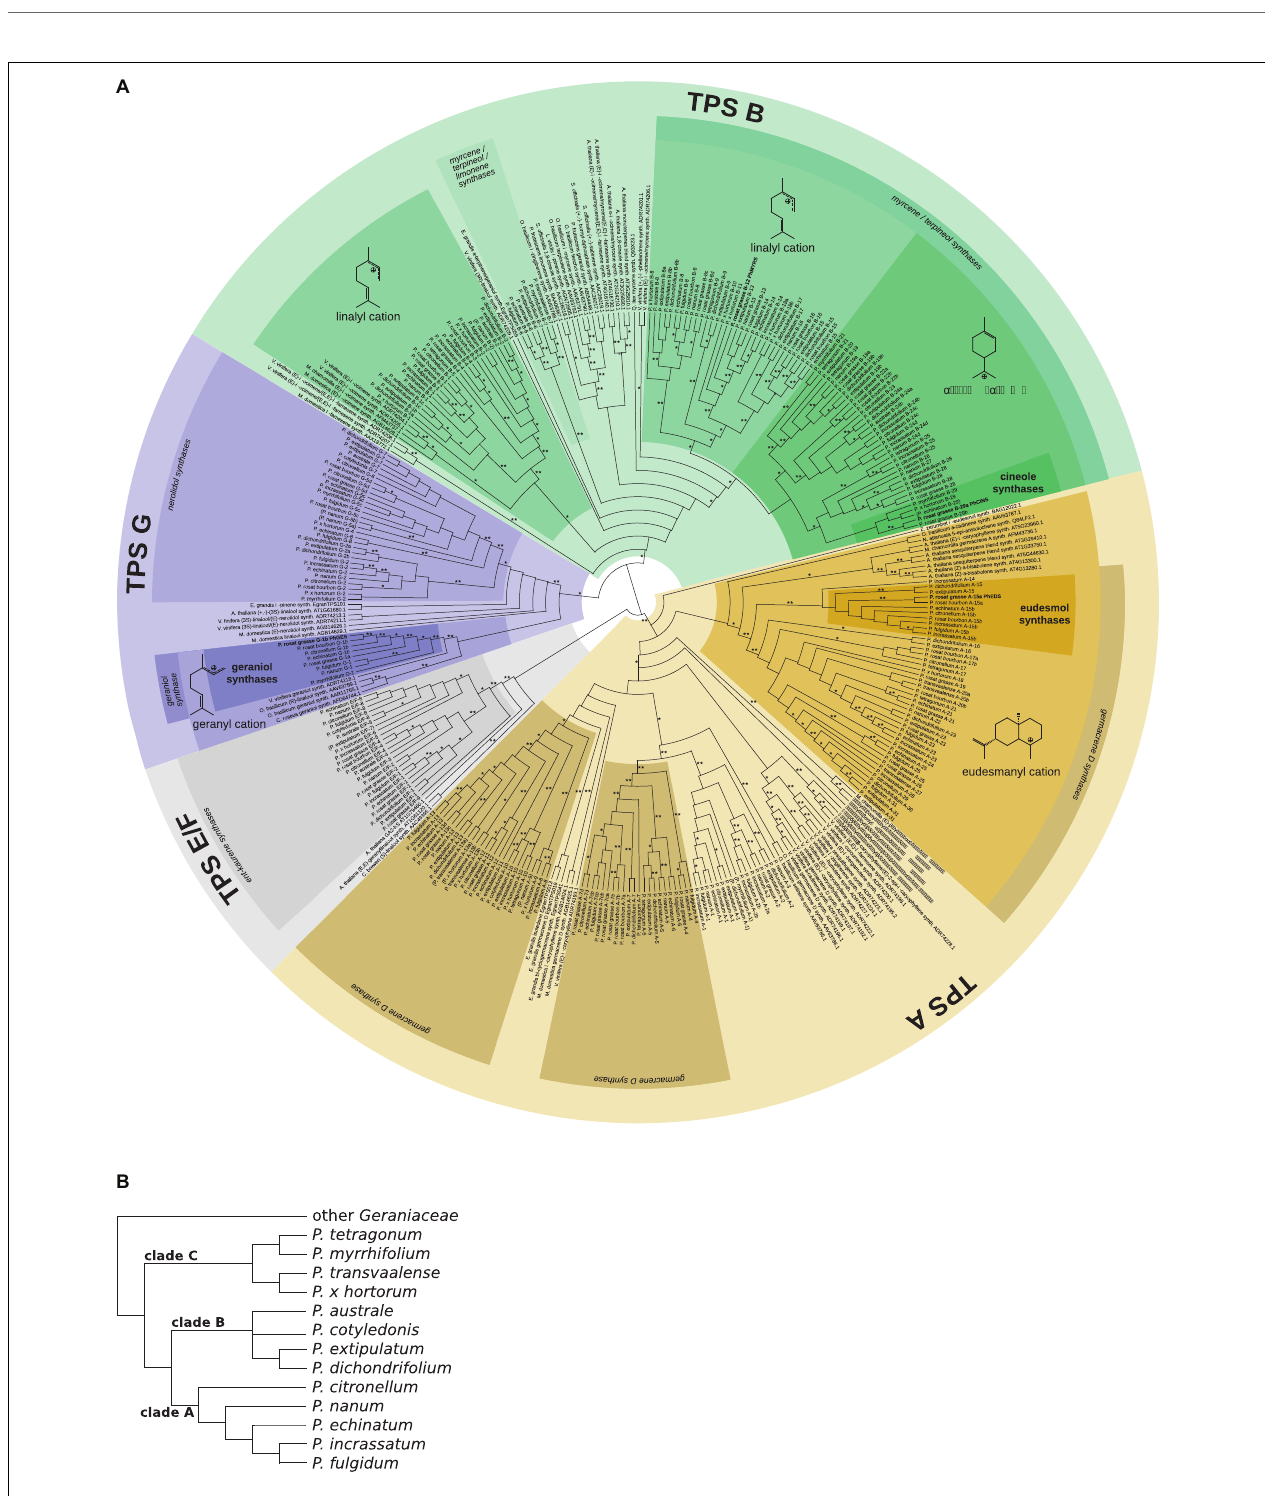
FIGURE 8 | Phylogeny of Pelargonium TPS and Pelargonium species. Maximum likelihood phylogeny of Pelargonium and of functionally characterised TPS from other species (A) . Classification of TPS is indicated by concentric circles, from the outside to the inside: TPS subfamilies, annotation from BLAST results, putative intermediary carbocation, and putative function from orthology relationships with functionally characterised enzymes. Carbocations were tentatively deduced from known reaction pathways and functionally characterised enzymes in the clade. Orthology relationships between TPS sequences are indicated in the name of the sequence using the subfamily letter followed by a number. Orthology was reconstructed from the known Pelargonium species phylogeny (B) , redrawn after (Weng et al., 2012). Some flexibility was allowed within each Pelargonium clade and sequences not belonging to the right clade are indicated in brackets. Sequences from pelargonium rosat were considered to cluster with P. citronellum sequences. Characterised TPS in this study are indicated in bold. Bootstrap support: ∗ ≥ 70, ∗∗ ≥ 90.